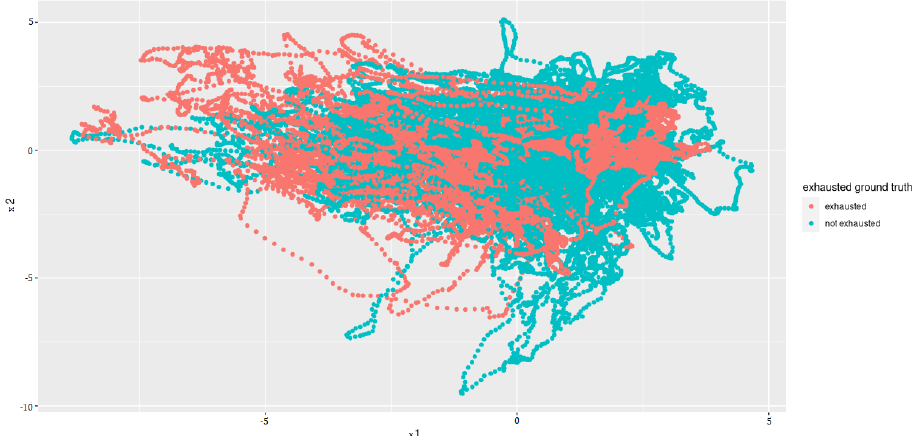
Figure 8. Principal Components 1 and 2 after the dimensionality